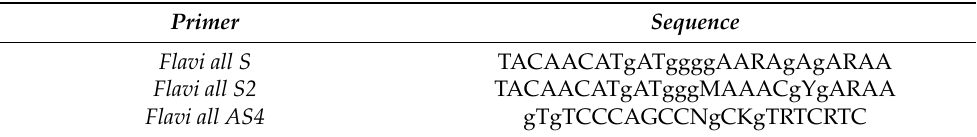
Table 2. Names and sequences of the primers used in the pan-flavivirus qPCR.